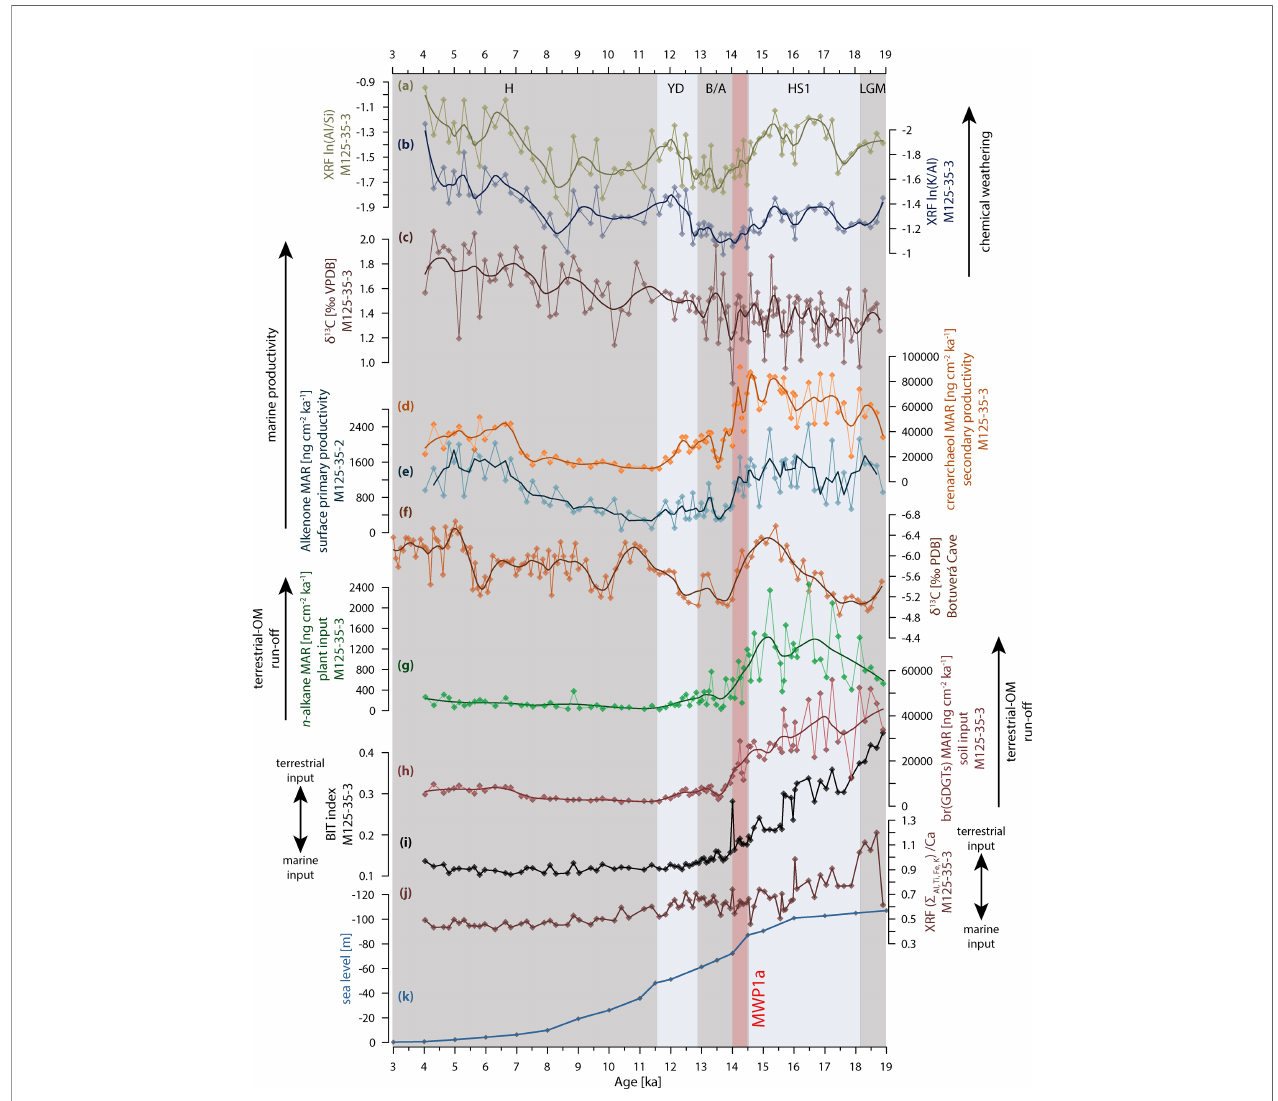
FIGURE 3 | Time series of lipid biomarker (D, E, G, H, I) , bulk sediment elemental composition (A, B, J) and foraminiferal geochemistry (C) data of Core M125-35- 3 (this study) compared to a deglacial sea level (K) sea level reconstruction (Austermann et al., 2013) and terrestrial speleothem d 13 C (F) of Botuvera ́ Cave (Cruz et al., 2005). Thick lines in panels a-h indicate 3-point running average. Bulk sediment elemental composition from Core M125-35-3: (A) ln(Al/Si), (B) ln(K/Al), j) ( S Fe, Al, Ti, K )/Ca. Lipid biomarker of Core M125-35-3): (D) Mass accumulation rate (MAR) of crenarchaeol, e) alkenone MAR, g) n -alkane MAR, (H) brGDGTs MAR, i) BIT index. (C) Stable carbon isotopes ( d 13 C) composition of Globigerinoides ruber (p). Arrows indicate direction of increases. Red shaded area marks the timing of Meltwater Pulse 1a (Brendryen et al., 2020). LGM, Last Glacial Maximum; HS1, Heinrich Stadial 1; B/A, Bølling-Allerød interstadial; YD, Younger Dryas; H, Holocene; MWP1a, Meltwater Pulse